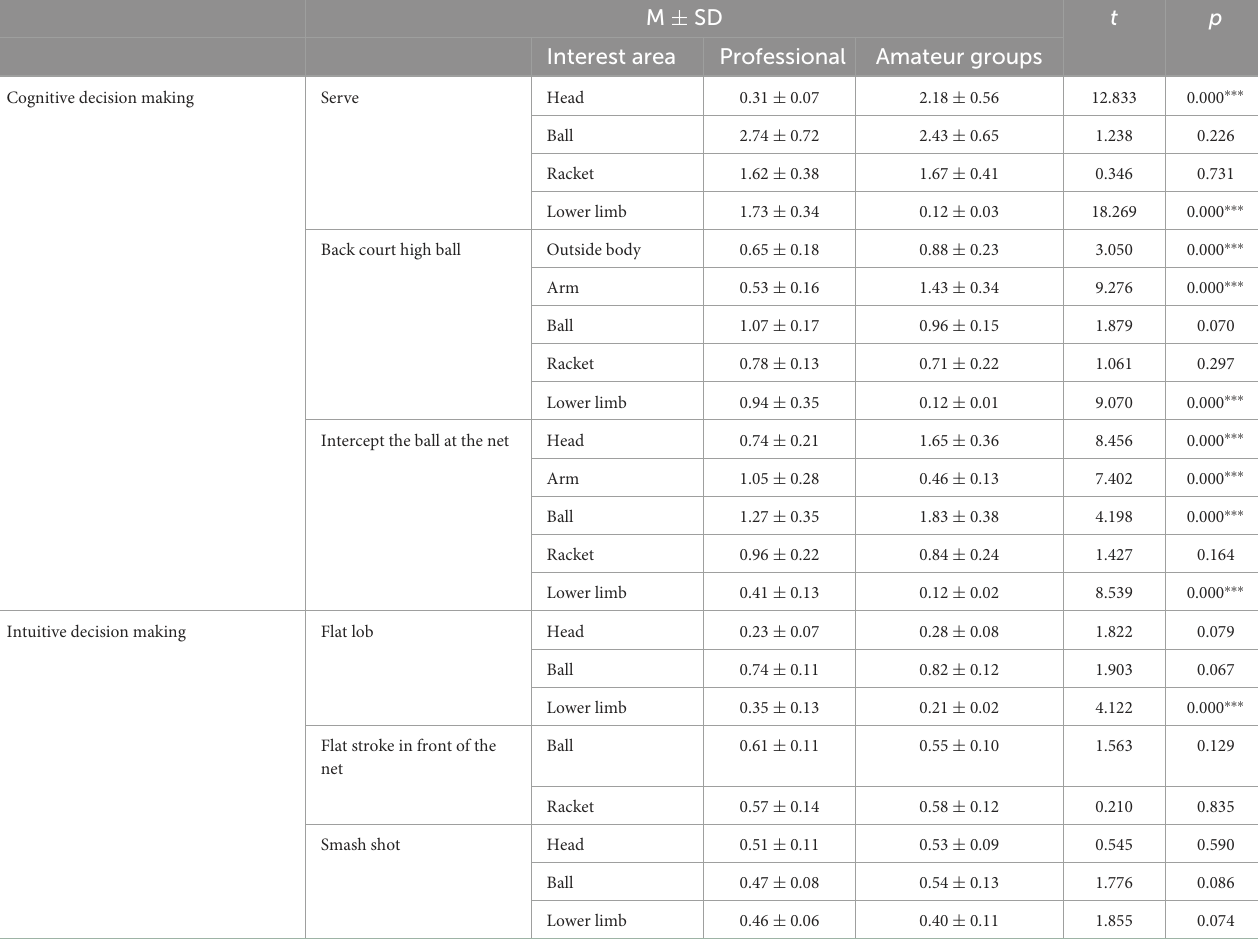
TABLE 7 A comparison of the number of fixation points in the different areas of interest between the two groups (unit: